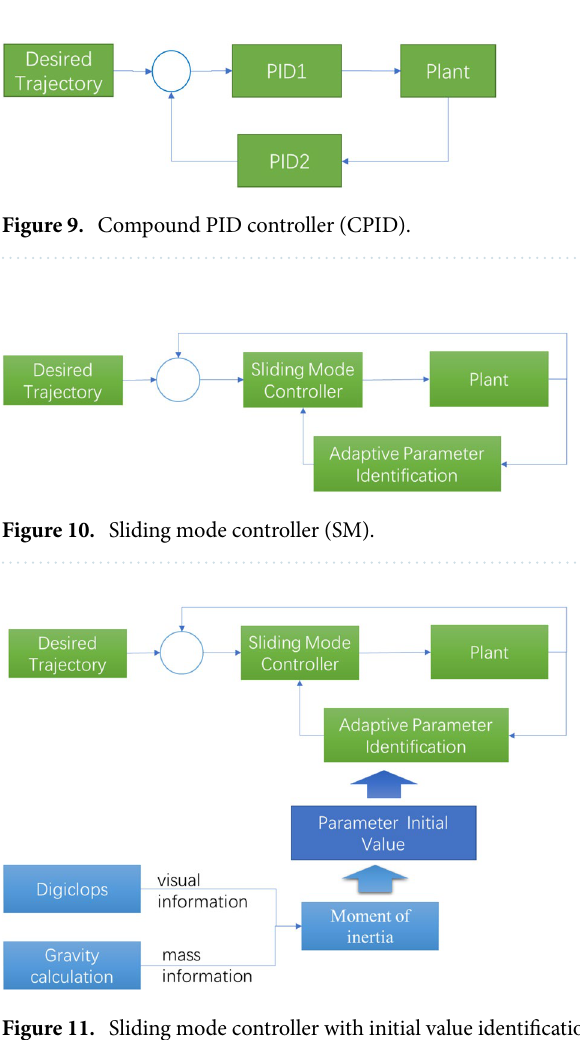
Figure 11. Sliding mode controller with initial value identification